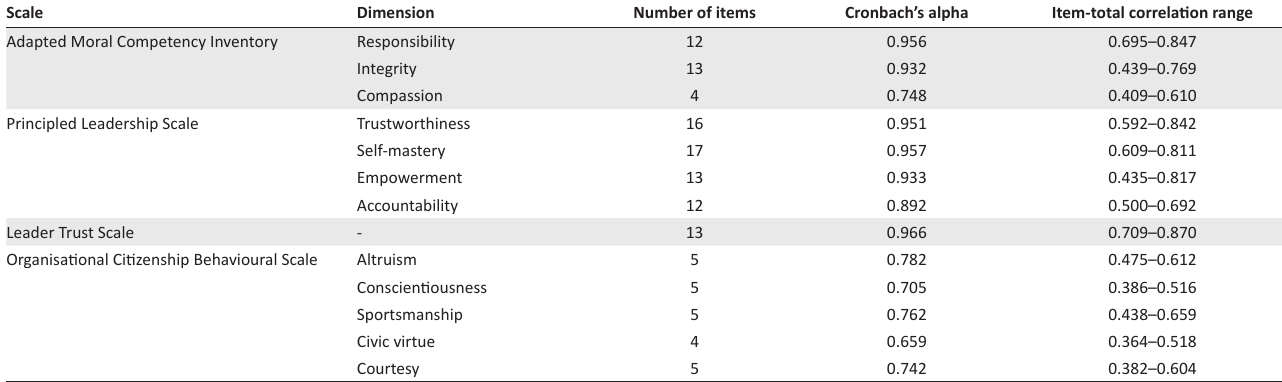
TABLE 2: Reliability results of the four scales. Scale